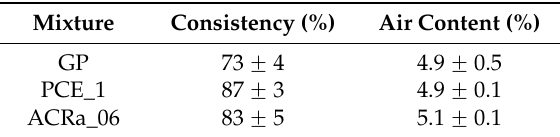
Table 3. Consistency and air content of GP, PCE_1, and ACRa_06 (average values of four and two measurements,